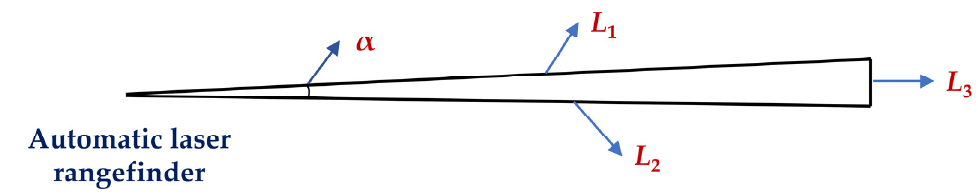
Figure 11. Schematic diagram of displacement numerical processing. The vertical displacement of the main tunnel vault V 1 , the ramp tunnel vault V 2 , the horizontal displacement of the main tunnel left arch waist H 3 , the horizontal displacement of the main tunnel right arch waist H 4 , the horizontal displacement of the ramp tunnel right arch waist H 5 , and the horizontal displacement of the ramp tunnel left arch waist H 6 were calculated using Formula (1).